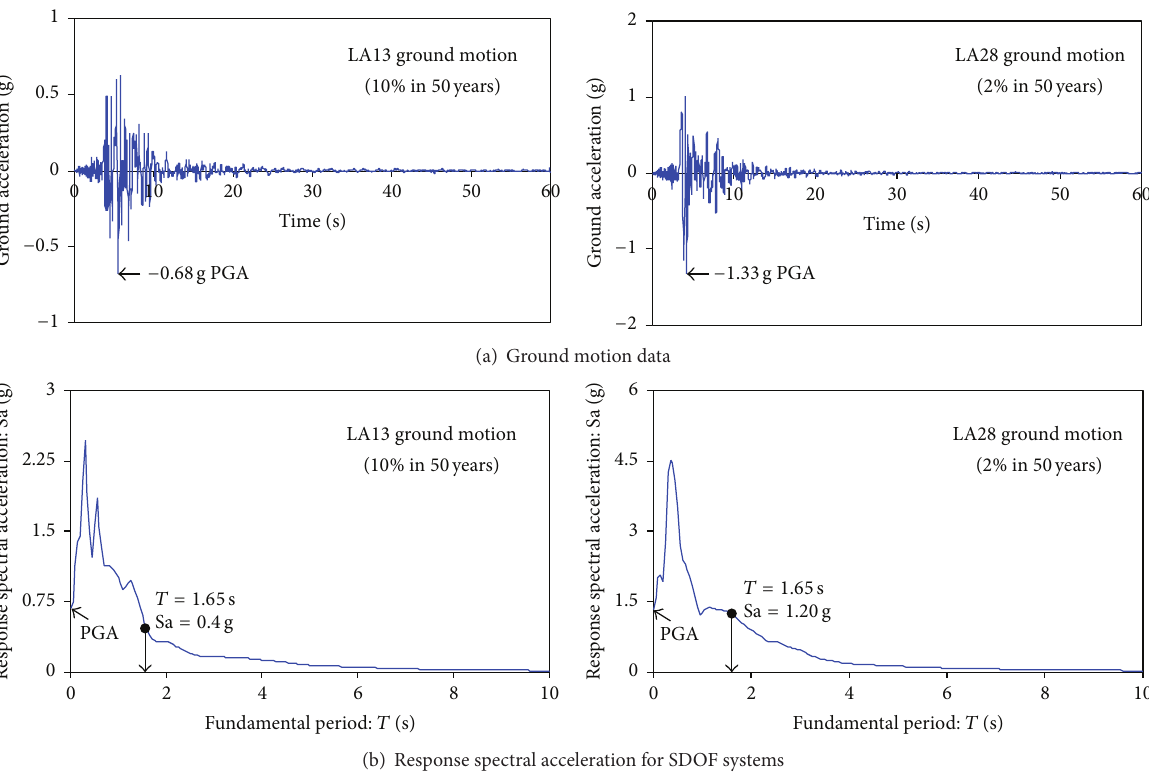
Figure 6: Representative ground motion data and response spectral accelerations (1.0 Scale Factor